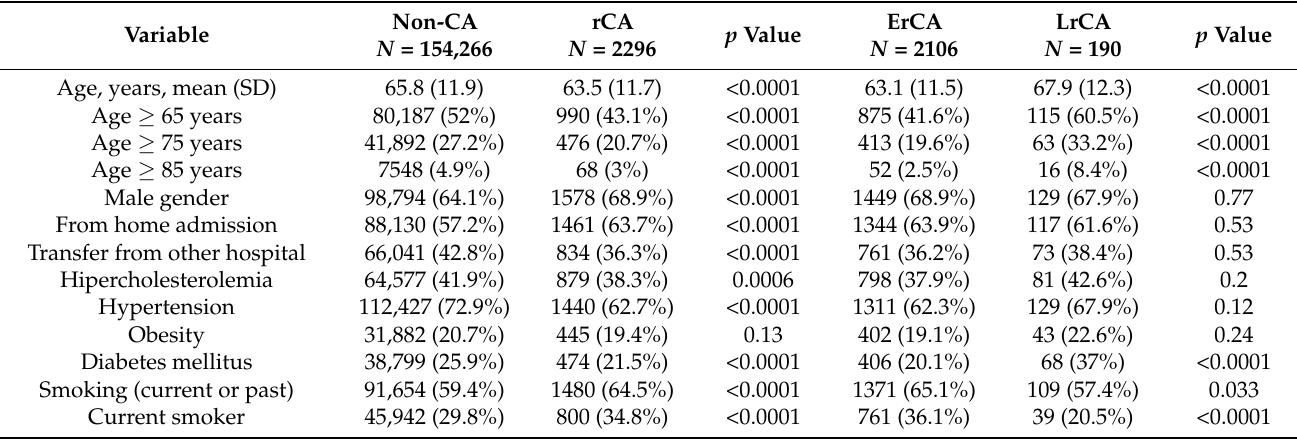
Table 1. Baseline clinical characteristics of patients without cardiac arrest and with ErCA and LrCA after acute myocardial infarction (only patients who were discharged after index